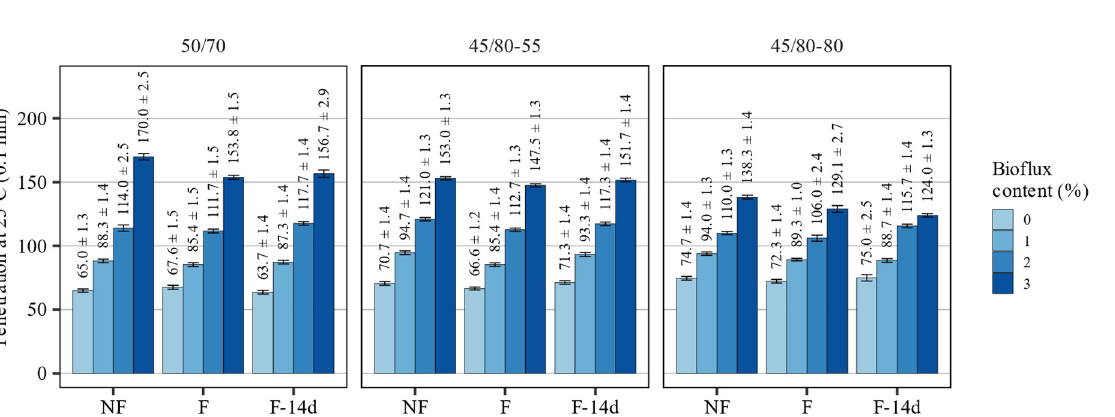
Figure 1. Results of penetration at 25 °C of the investigated asphalt binders.